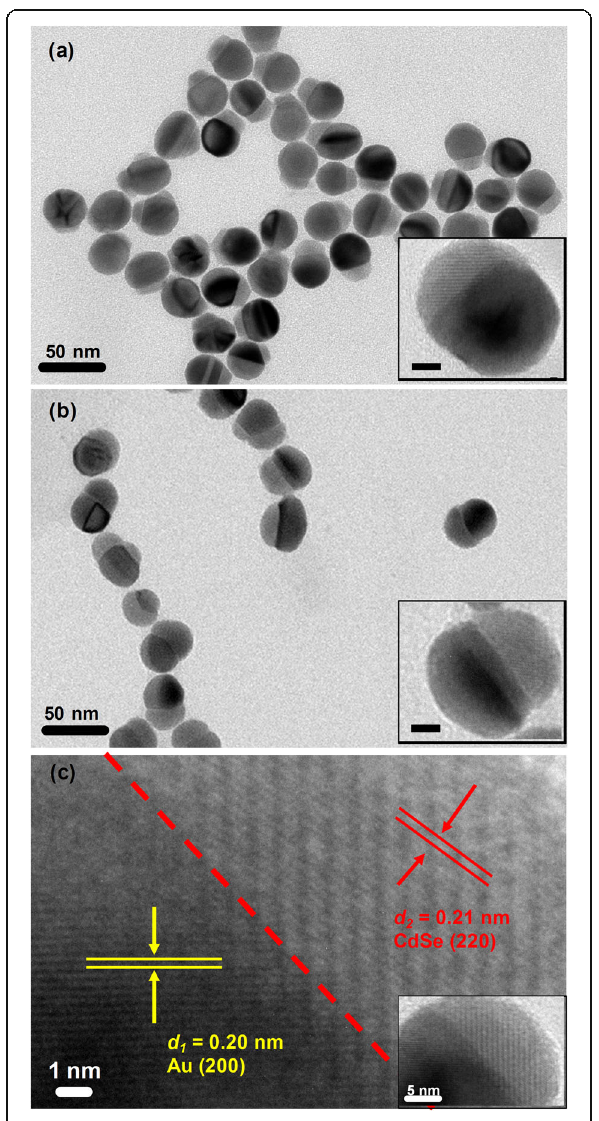
Fig. 2 TEM images of Au/CdSe Janus nanospheres at pH = 2.5 with different reaction times. a 2 h. b 3 h. The insets show a single Janus nanosphere. The scale bars in the insets are 5 nm. c HRTEM image of the interfacial area of Au/CdSe Janus nanospheres